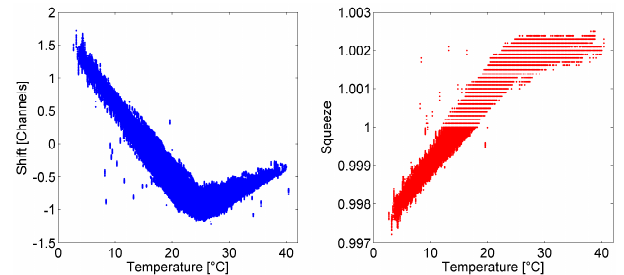
Figure 5. Shift and squeeze for a DOAS fit only containing one reference spectrum with an instrument temperature of 15 ◦ C. For this plot half a year of data were evaluated. It can be clearly seen that the instrument pixel-to-wavelength alignment is influenced by changes in the ambient